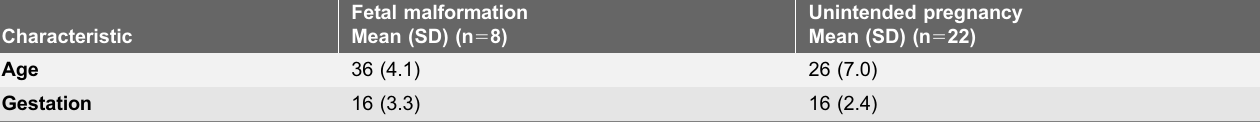
Table 2. Age of the participating women and gestational week at the induced